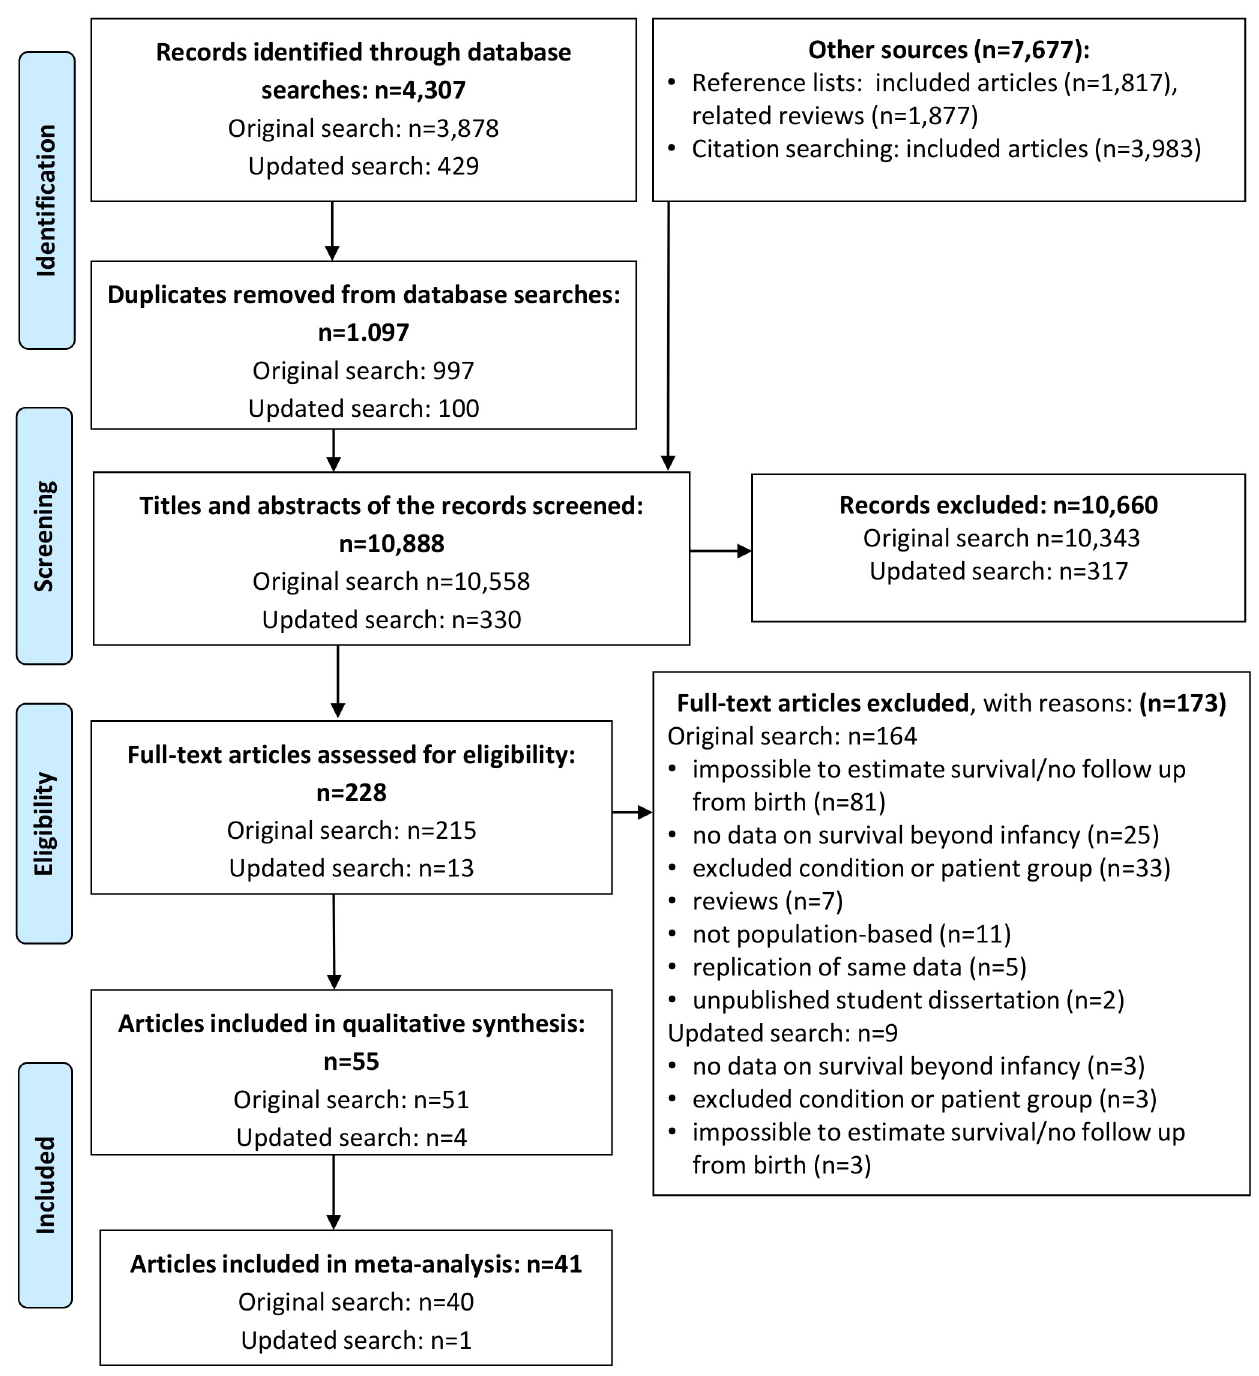
Fig 1. PRISMA flowchart of searches, screening, and study selection. PRISMA, Preferred Reporting Items for Systematic Reviews and Meta-Analyses.